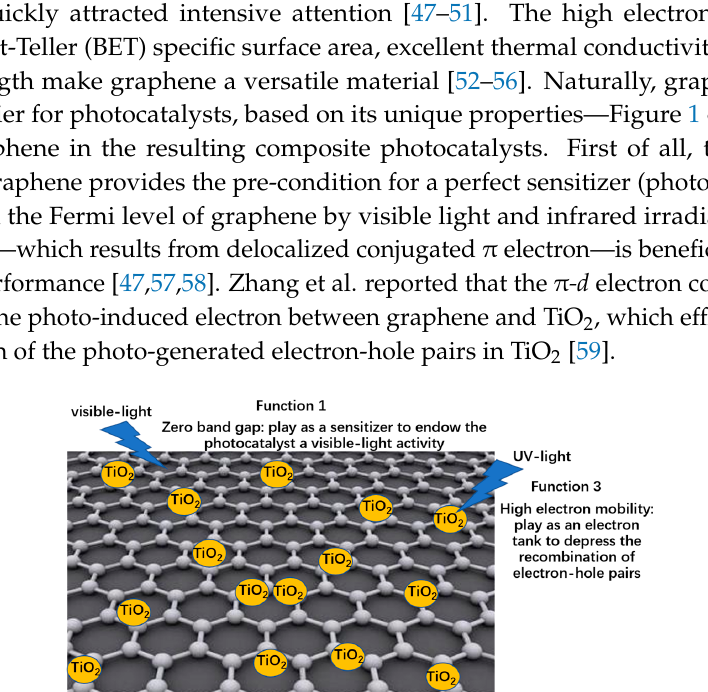
Figure 2. Overview of different research areas of graphene-TiO 2 composites. Reproduced with permission from [15]. Copyright Elsevier, 2011. Reproduced with permission from [75]. Copyright ACS, 2013. Reproduced with permission from [76]. Copyright ACS, 2013.